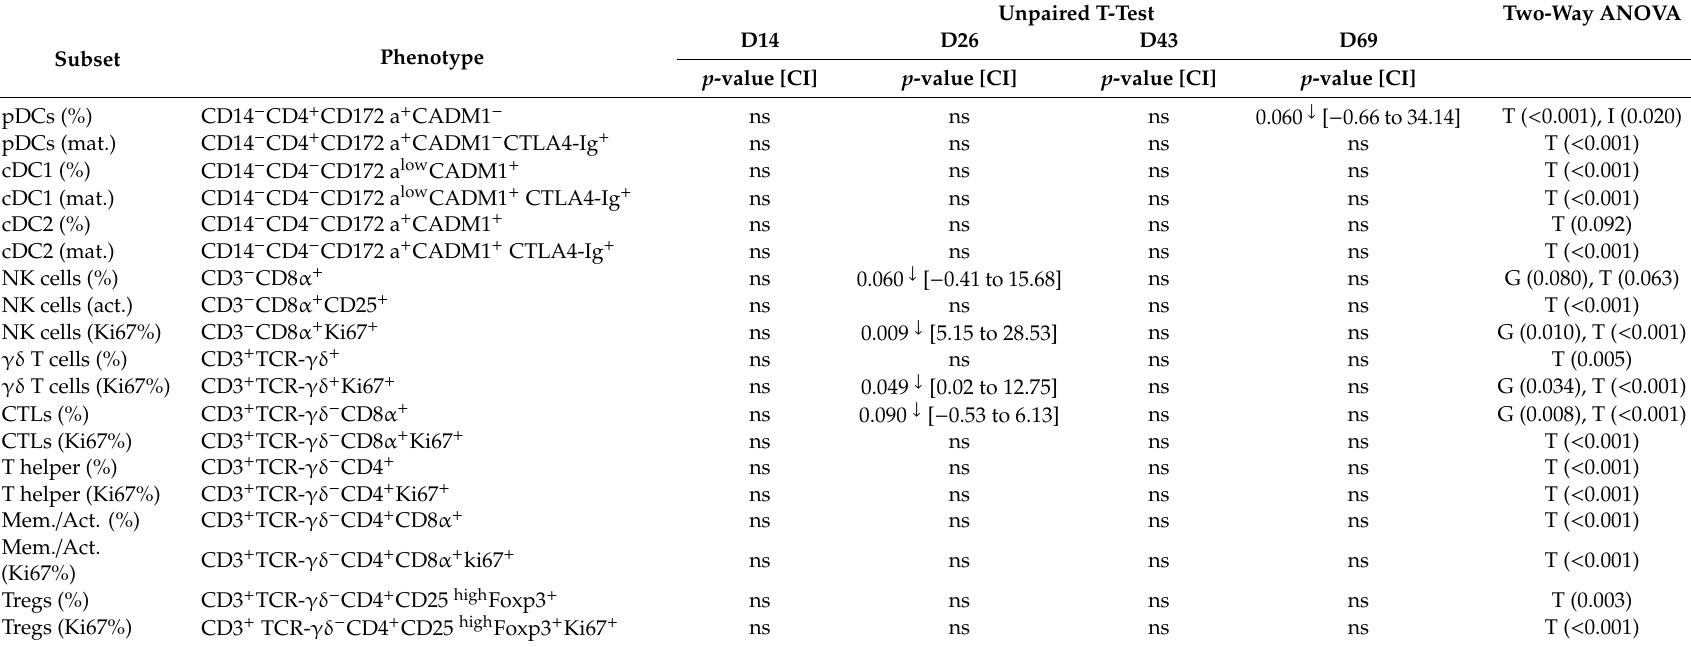
Table 2. Cell analysis of DCs, NK cells and T cells in PBMCs between treatment groups over time.